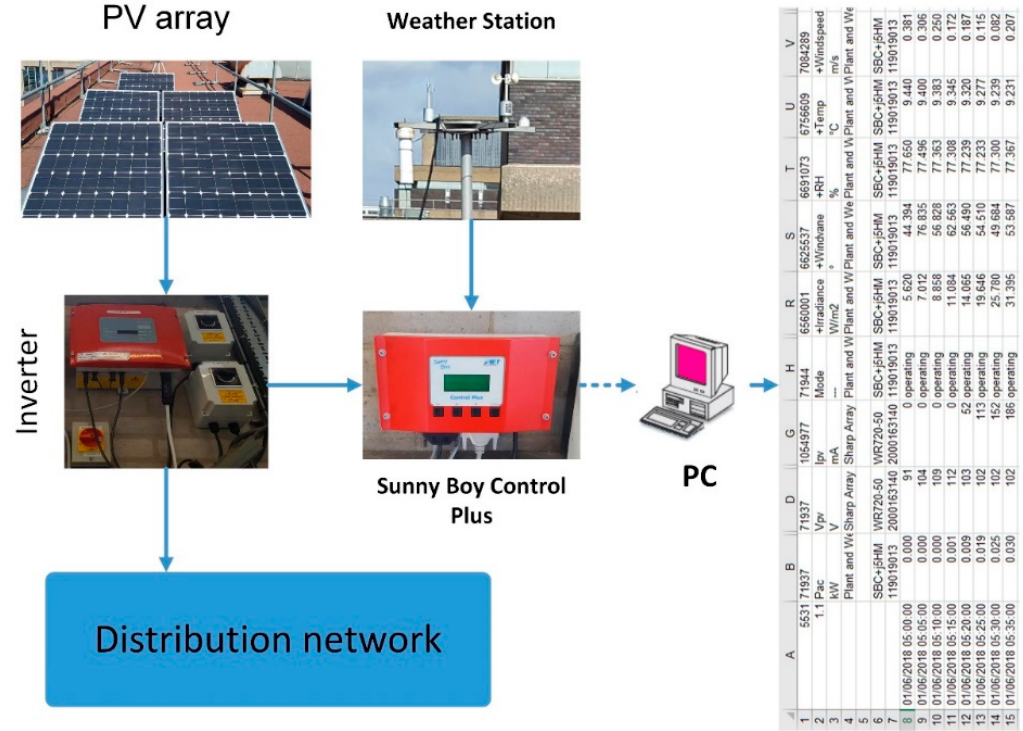
Figure 6. A general diagram of data collection system.